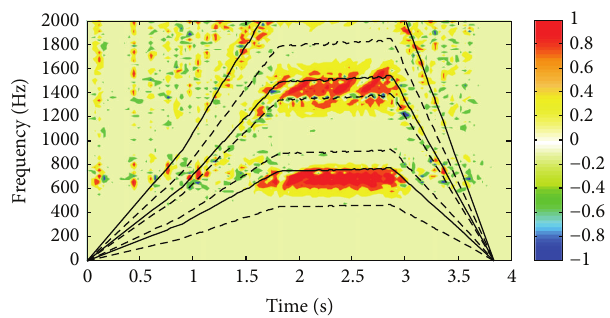
Figure 11: Contour plot of difference between HWT of healthy and damaged model results, with gear mesh frequencies (GMF) and integer harmonics